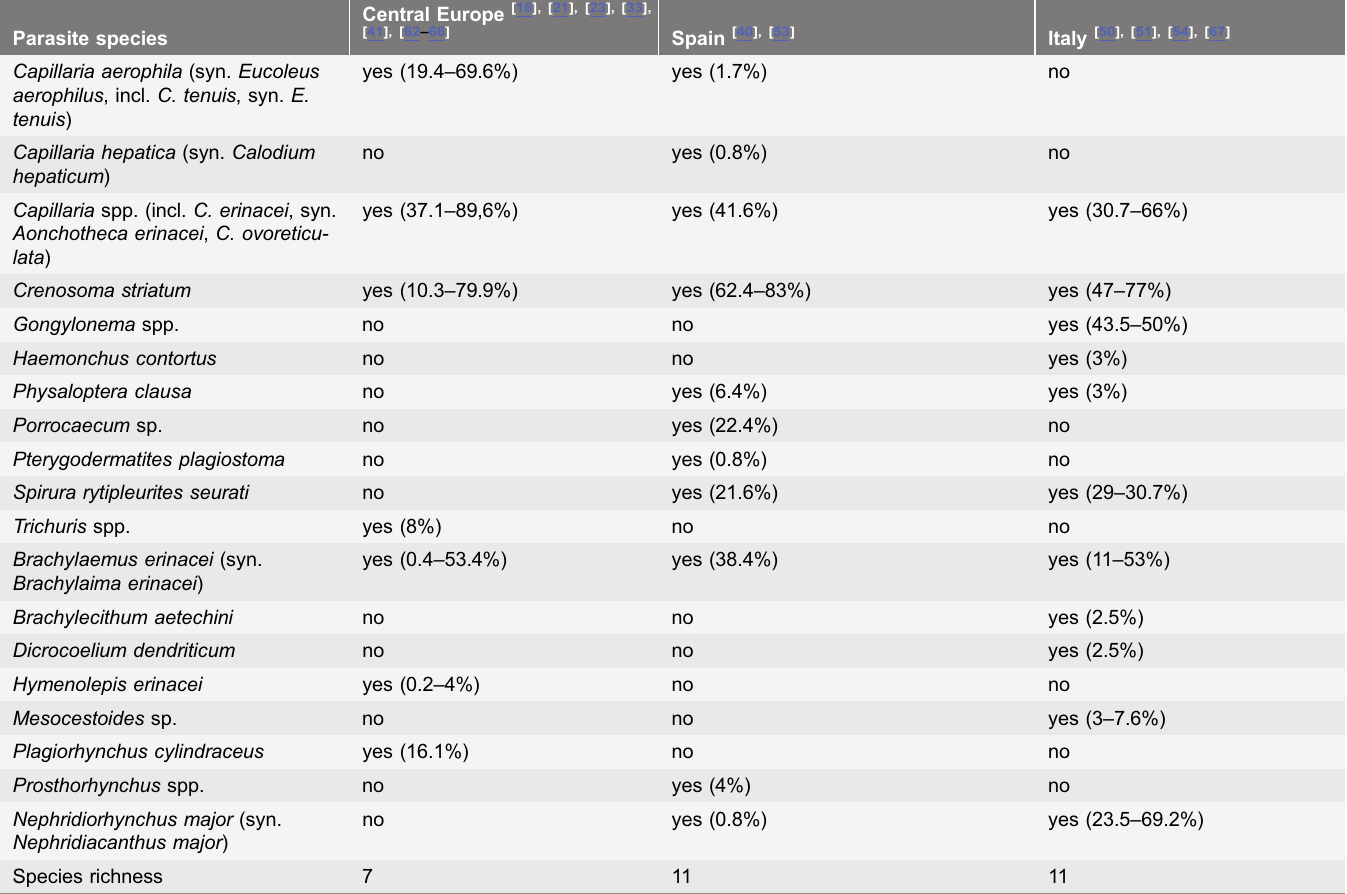
Table 2. Comparison of the macroparasite fauna of Erinaceus europaeus from Central Europe (without the contact zones of E. europaeus and E. roumanicus in the Czech Republic and Poland) and its’ southern European refuges. Central Europe [16], [21], [23], [33], [41], [62–66] Spain [40], [53] Italy [50], [51], [54], [67] Parasite species Capillaria aerophila (syn. Eucoleus yes (19.4–69.6%) yes aerophilus , incl. C. tenuis , syn. E. tenuis )